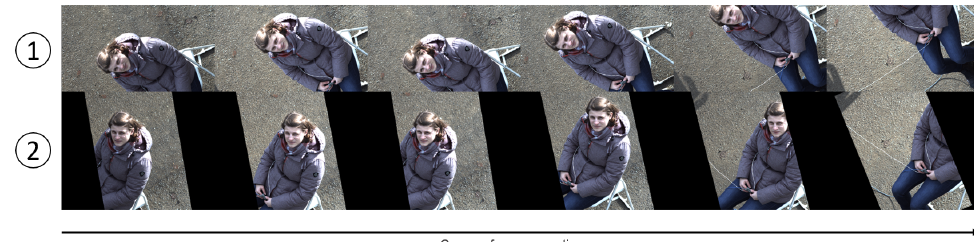
Figure 2. Time series of recorded camera frames before (1) and after (2) image stabilization.